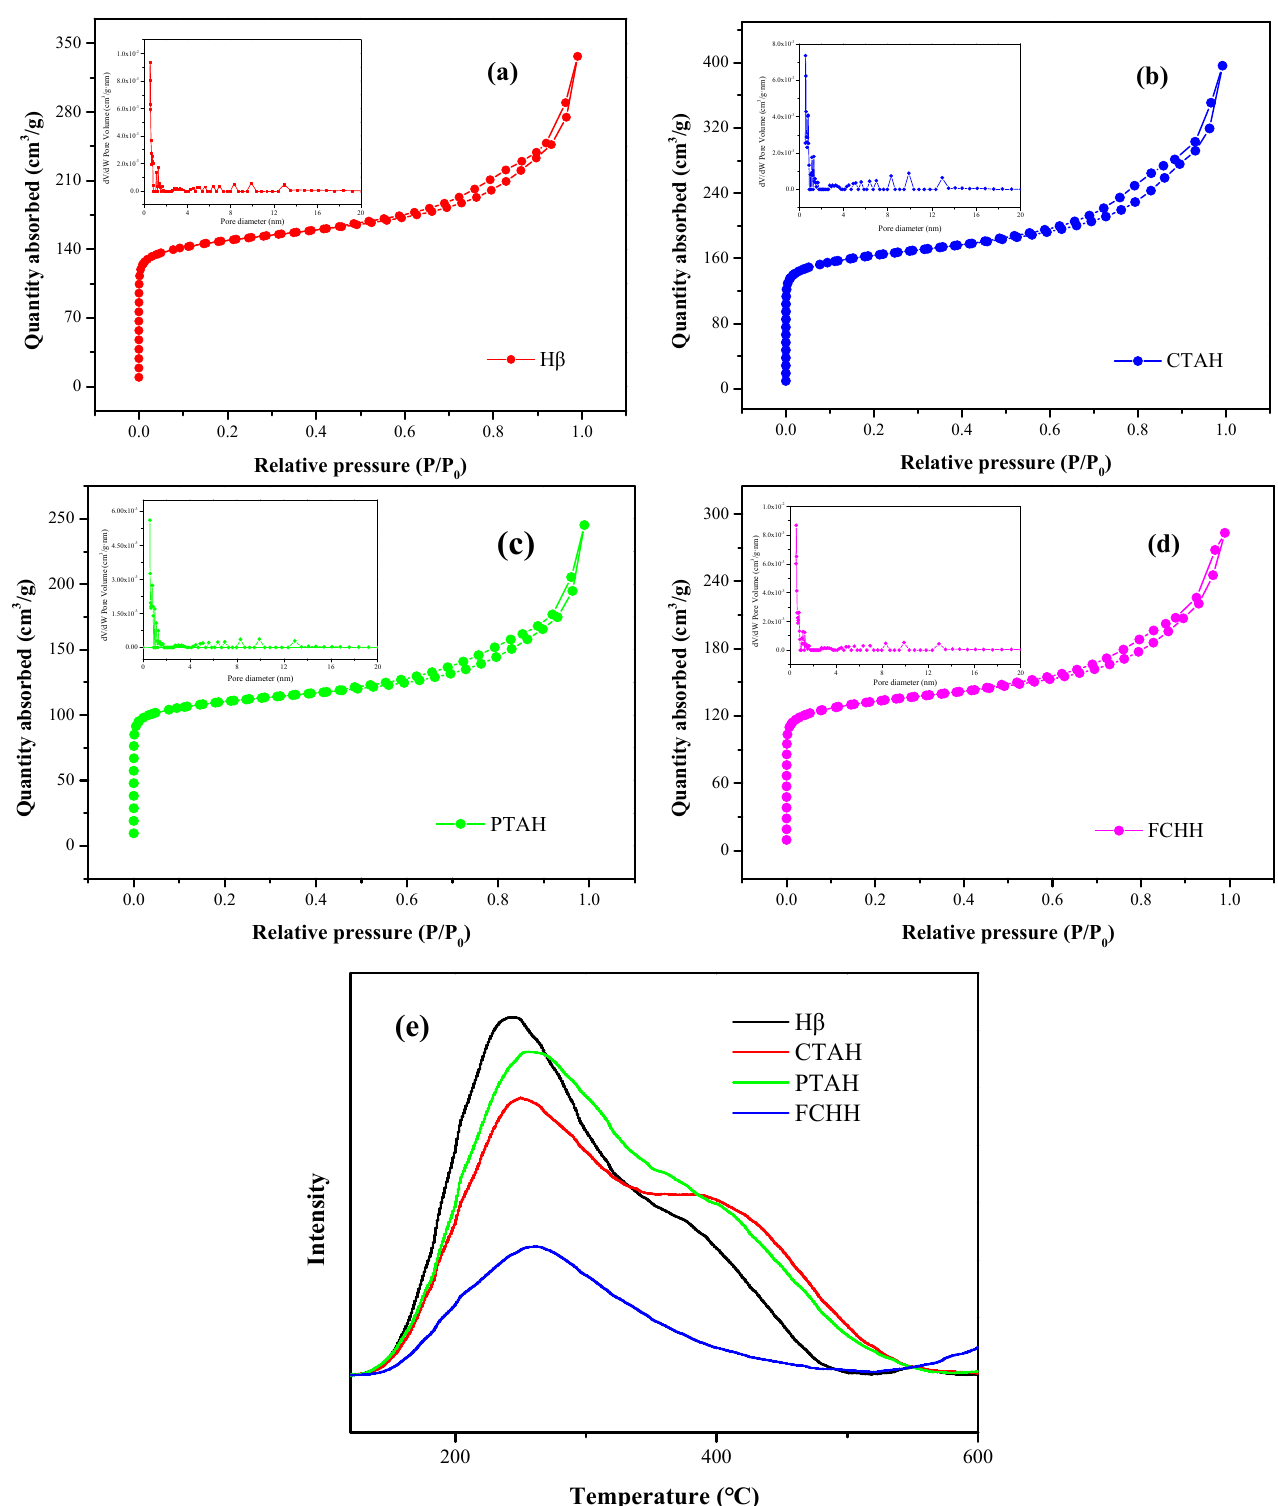
Figure 4. ( a – d ): N 2 adsorption and desorption isotherms and pore size distribution of various catalysts; ( e ) NH 3 -TPD curves of various catalysts. H β : Hydrogen type of zeolite beta; CTAH: Citric acid loaded on H β ; PTAH: Phosphotungstic acid loaded on H β ; FCHH: Ferric chloride hexahydrate loaded on H β .